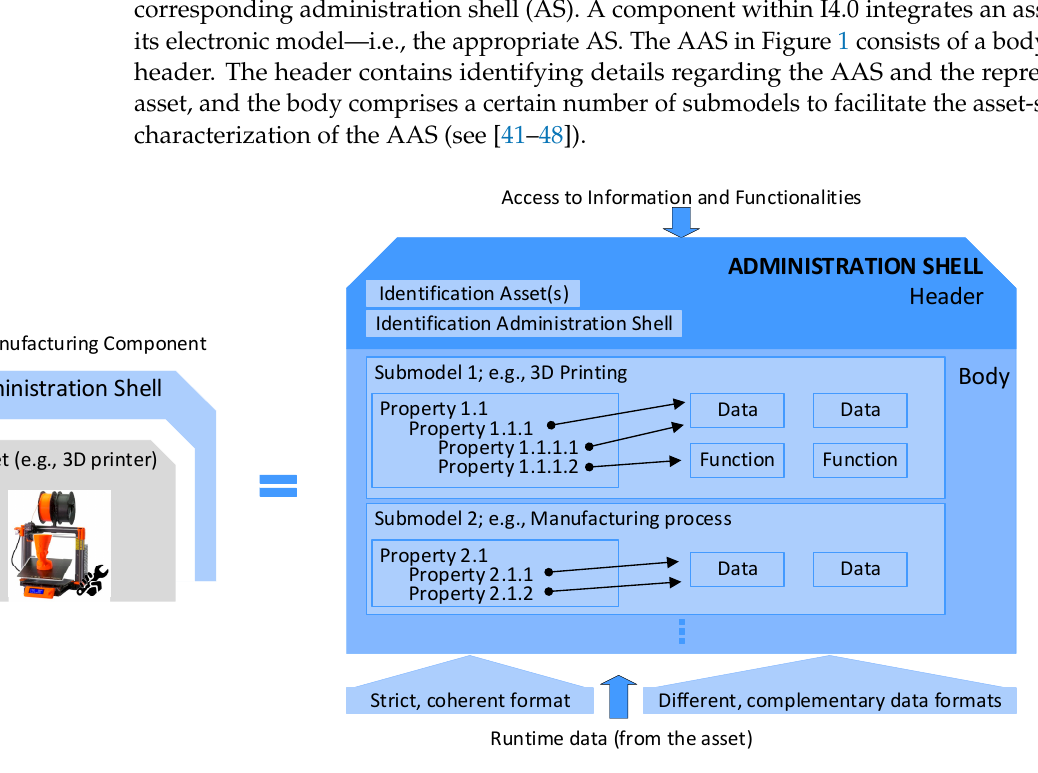
Figure 1. The detailed structure of an AAS.